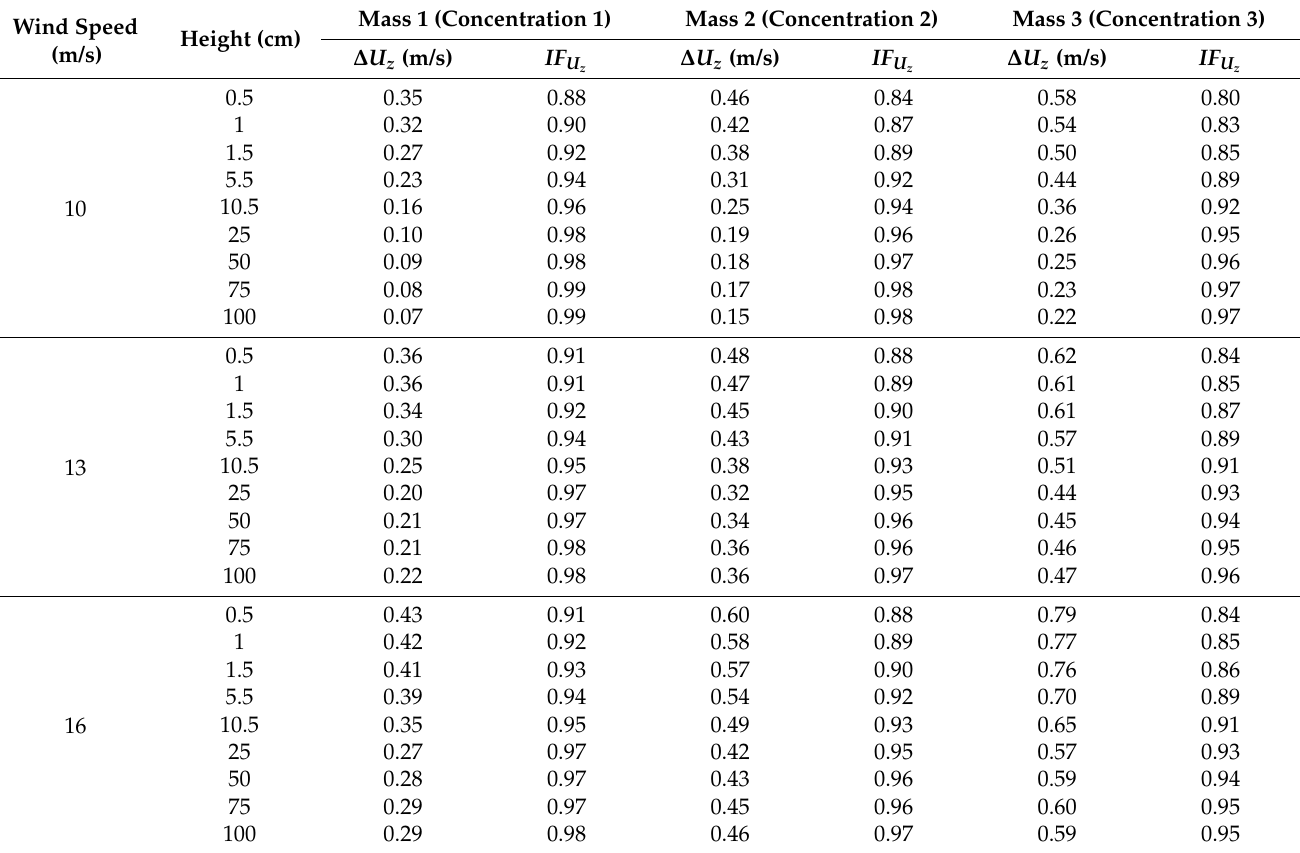
Table 2. The effect of moving grains on wind speeds at different